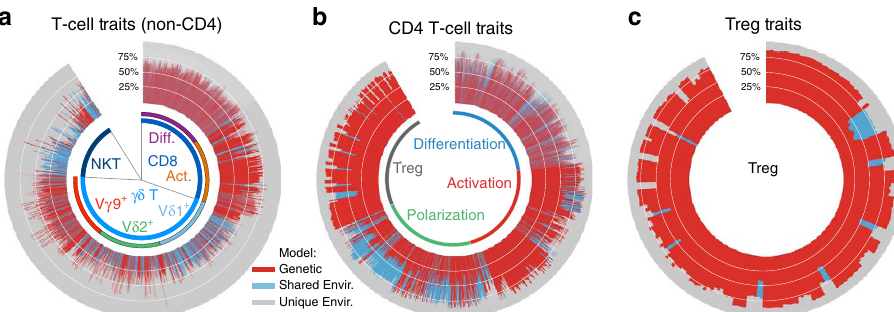
Figure 3 | Trait variation determination in Tcell subsets. The subset of Tcell traits shown in Fig. 2a are expanded. ( a , b ) T-cell traits for non-CD4 Tcells ( a ), including CD8 T, gd Tand NKTcells (defined as CD1d-multimer binding), and for CD4 Tcells ( b ). Traits were arranged according to the subsets from which they were defined: ‘Differentiation’—subsets defined by the markers CD27, CD28, CD31, CD45RA, CD57, CD95, CD127 and CD244 (Staining panel 1; see Supplementary Fig. 2 in Roederer et al. 8 ). ‘Activation’—subsets defined by the markers CD25, CD38, HLA-DR and CD279/PD-1 (Staining panel 2). ‘Polarization’—subsets defined by the markers CCR4, CCR6, CCR10, CXCR3 and CXCR5 (Staining panel 3). ‘Treg’—subsets defined by the markers CD25, CD127, CD39, CD45RO and CD73 (Staining panel 2). ( c ) Traits for only Treg cells (expressing CD39 and/or CD73). Of the 20 traits showing shared environmental influence, 18 arise from subsets co-expressing CD25 and CD73 with variable expression of other